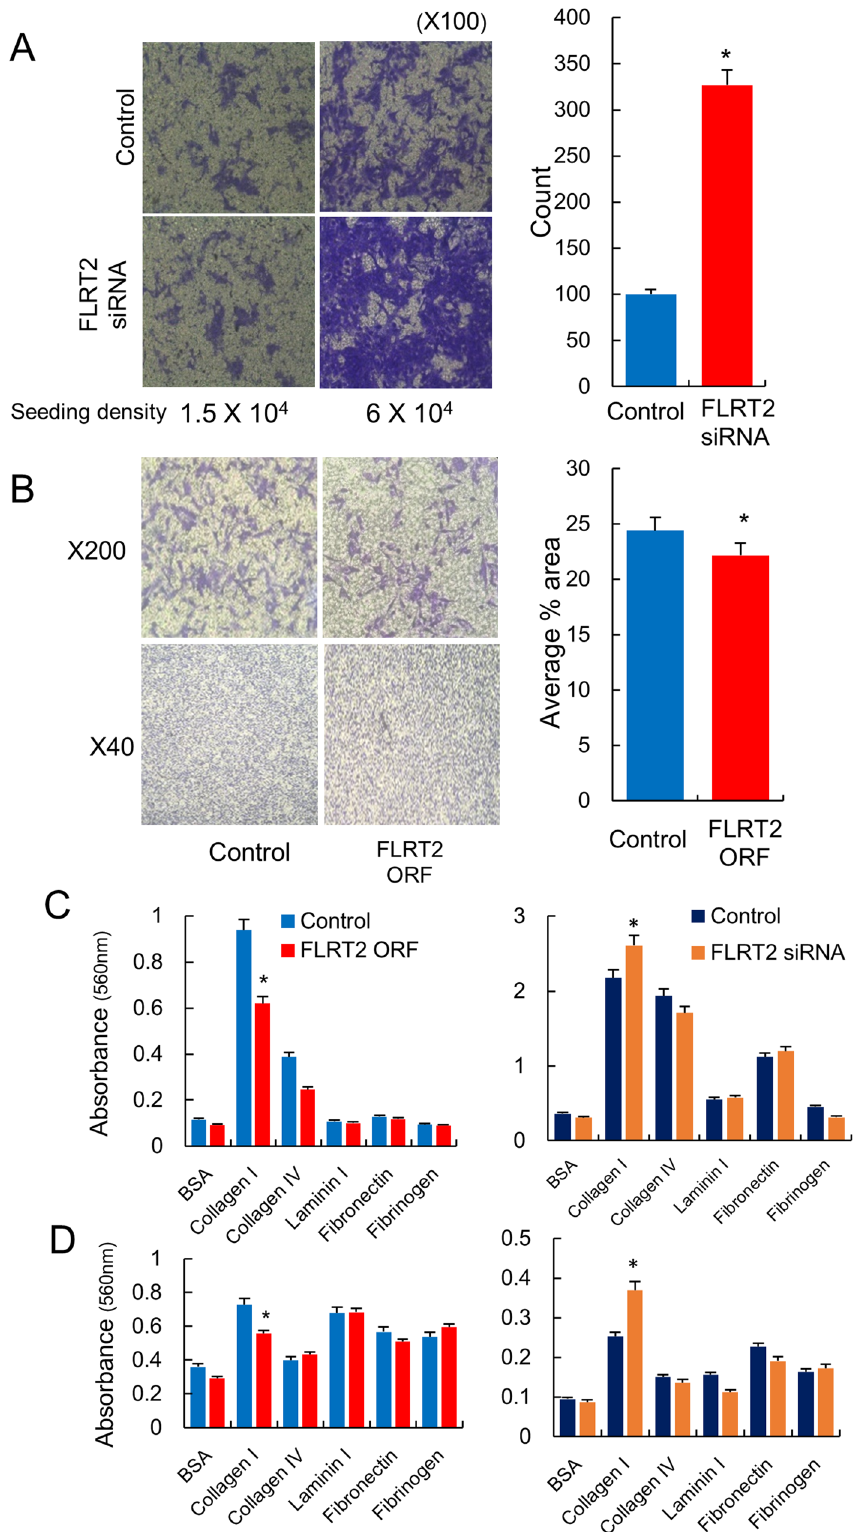
Figure 5. FLRT2 suppresses migration and adhesion. FLRT2 was downregulated with an siRNA in MCF-10A, normal breast cells ( A ) or upregulated in MDA-MB-231, breast cancer cells ( B ) and the effect on cell migration was examined. The images are taken from at least three independent experiments, and the results are shown as means with standard errors in the bar graphs. For adhesion assay, FLRT2 was upregulated or downregulated in MCF-7 ( C ) and MCF-10A ( D ), and the effect on cell adhesion was examined. The results are from three independent experiments and shown as the mean ±